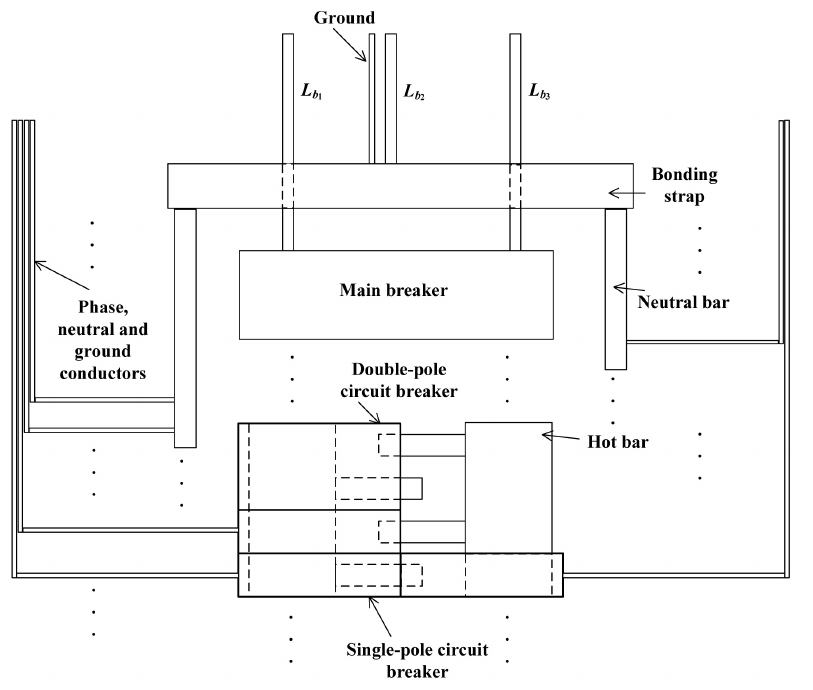
Figure 4. The topology of a 200 A